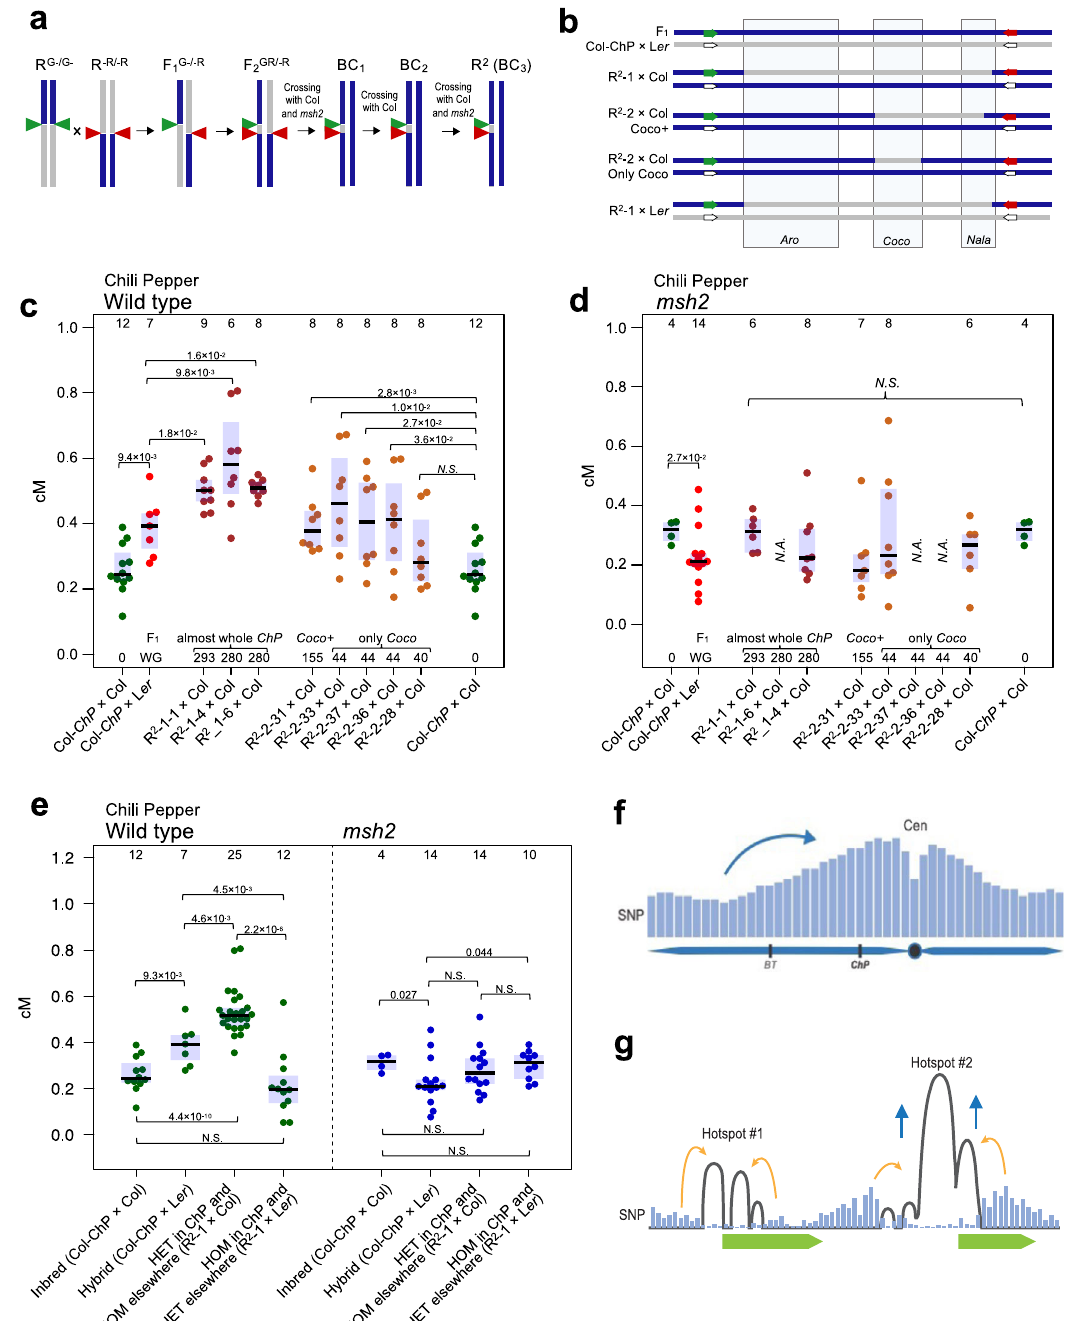
Fig. 8 | Direct effect of polymorphisms on MSH2-dependent CO targeting withintheChPinterval.a DiagramillustratingtheisolationoftheR 2 lines.Double green (G-/G-) and double red (-R/-R) seeds were selected from the progeny of sequenced recombinants and crossed (F 1 ). Recombinant GR/-R F 2 seeds were visually selected and backcrossed to wild-type or msh2 plants; at each generation, GR/--seedswereselected.TheBC 3 plantswereusedtomeasureChPCOfrequency. b Polymorphism pattern for different R 2 crosses. The chromosome carrying fl uorescentreporters(greenandredarrows)containsasegmentinheritedfromthe L er parent (gray). The Col-ChP × L er F 1 cross is shown for comparison. Hotspot positions are indicated in rectangles. c ChP CO frequency in R 2 lines. Each dataset corresponds to an independent R 2 line; The numbers below each bar indicate the number of SNPs differentiating homologous chromosomes. WG whole-genome. The center line of a boxplot indicates the mean; the upper and lower bounds indicate the 75th and 25th percentiles, respectively. Each dot represents one